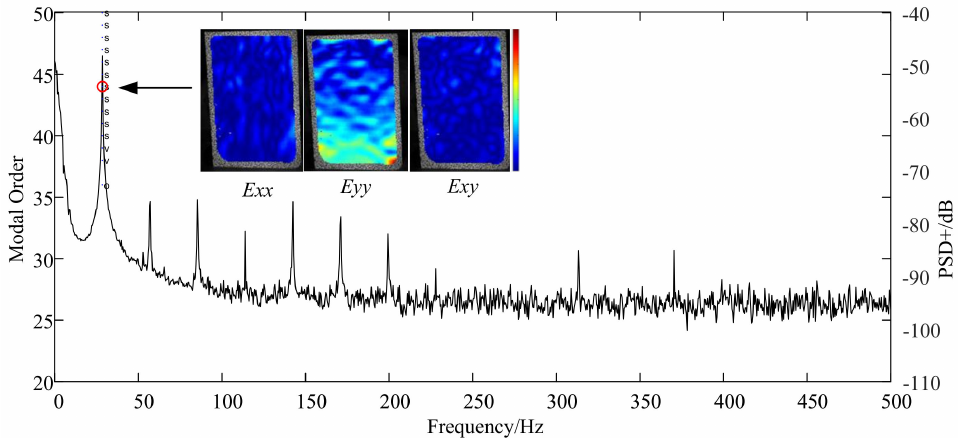
Figure 11. Stable chart and the first order of strain mode